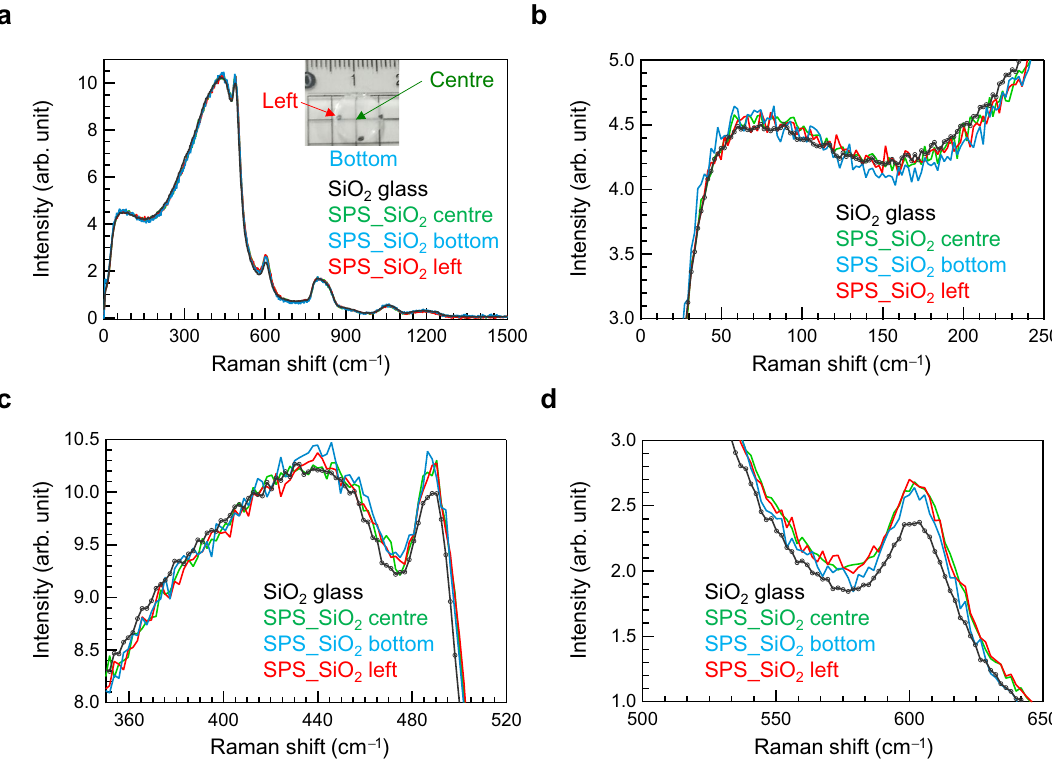
Figure 7. Micro-Raman spectra of SPS-SiO 2 glass recorded with HH polarisation. ( a ) Micro-Raman spectra of SPS-SiO 2 glass prepared at 6 MPa, 1400 °C along with that of SiO 2 glass. The inset shows the photograph of the SPS-SiO 2 glass marked with the measurement positions. Enlarged Raman spectra showing the ( b ) boson peak, ( c ) D 1 peak, and ( d ) D 2